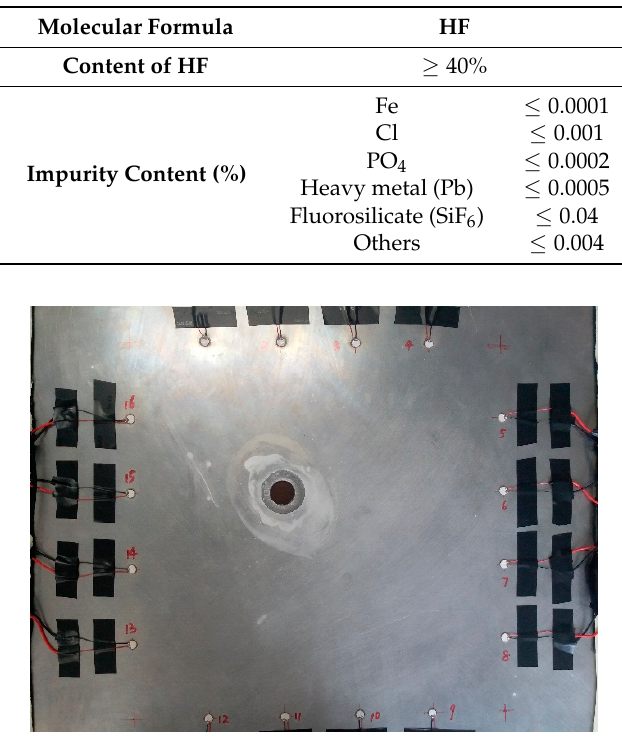
Figure 10. The specimen corroded by hydrofluoric acid.